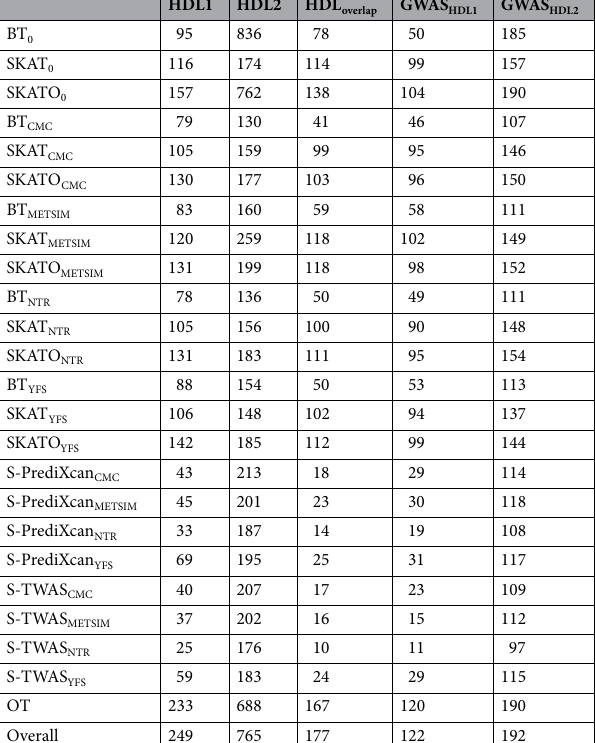
Table 5. The number of genes identified by each method for the two lipids data sets. The subscript denotes BT, SKAT, and SKATO using eQTL—derived weights; CMC, METSIM, NTR, and YFS indicate the resources to obtain the eQTL—derived weights. 0 indicates the methods without using any weights. HDL1 indicates the number of genes identified by each method for HDL1 data; HDL2 indicates the number of genes identified by each method for HDL2 data; HDL overall indicates the number of overlapping genes identified by both HDL1 and HDL2 data sets; GWAS HDL1 and GWAS HDL2 indicate the numbers of genome-wide significant genes that are reported in the GWAS catalog and are also identified by each method for HDL1 and HDL2, respectively.